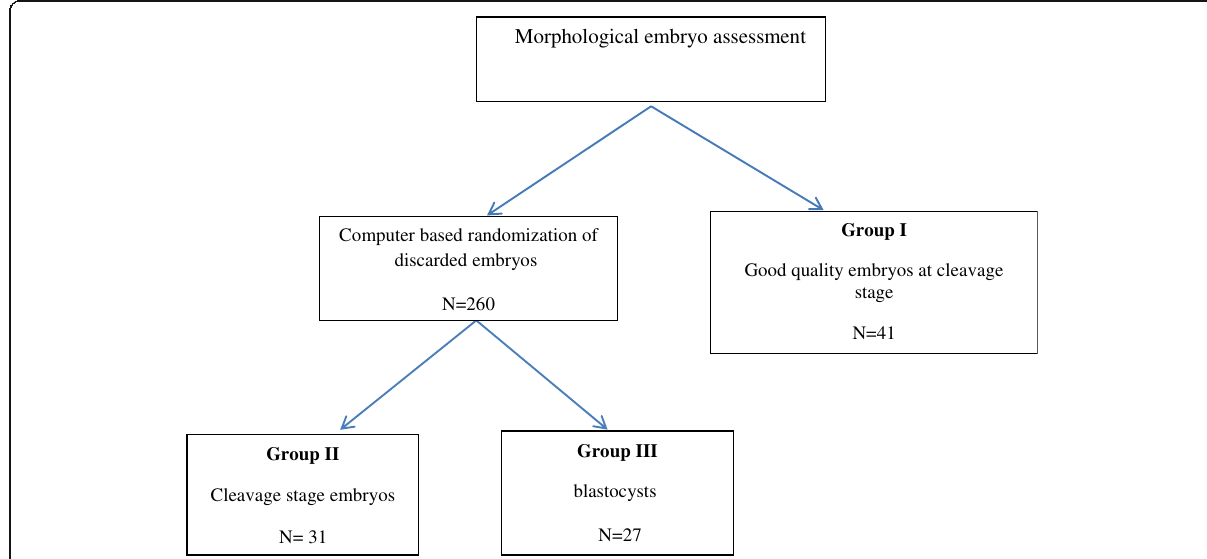
Fig. 1 Diagram for the group categorization of human embryos in this study. The chromosomal status in three groups was studied by multi- color fluorescence in situ hybridization (FISH)